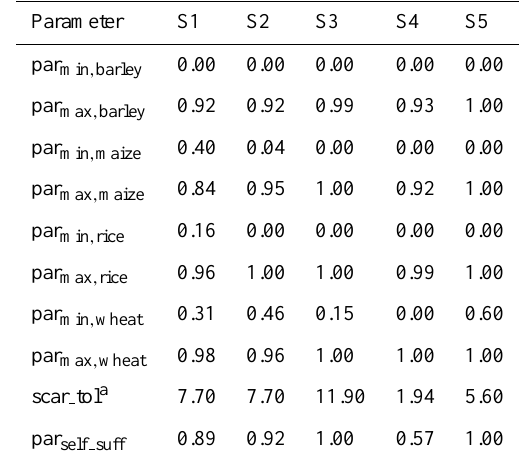
Table 1. The optimized LP model parameters obtained for all sce-